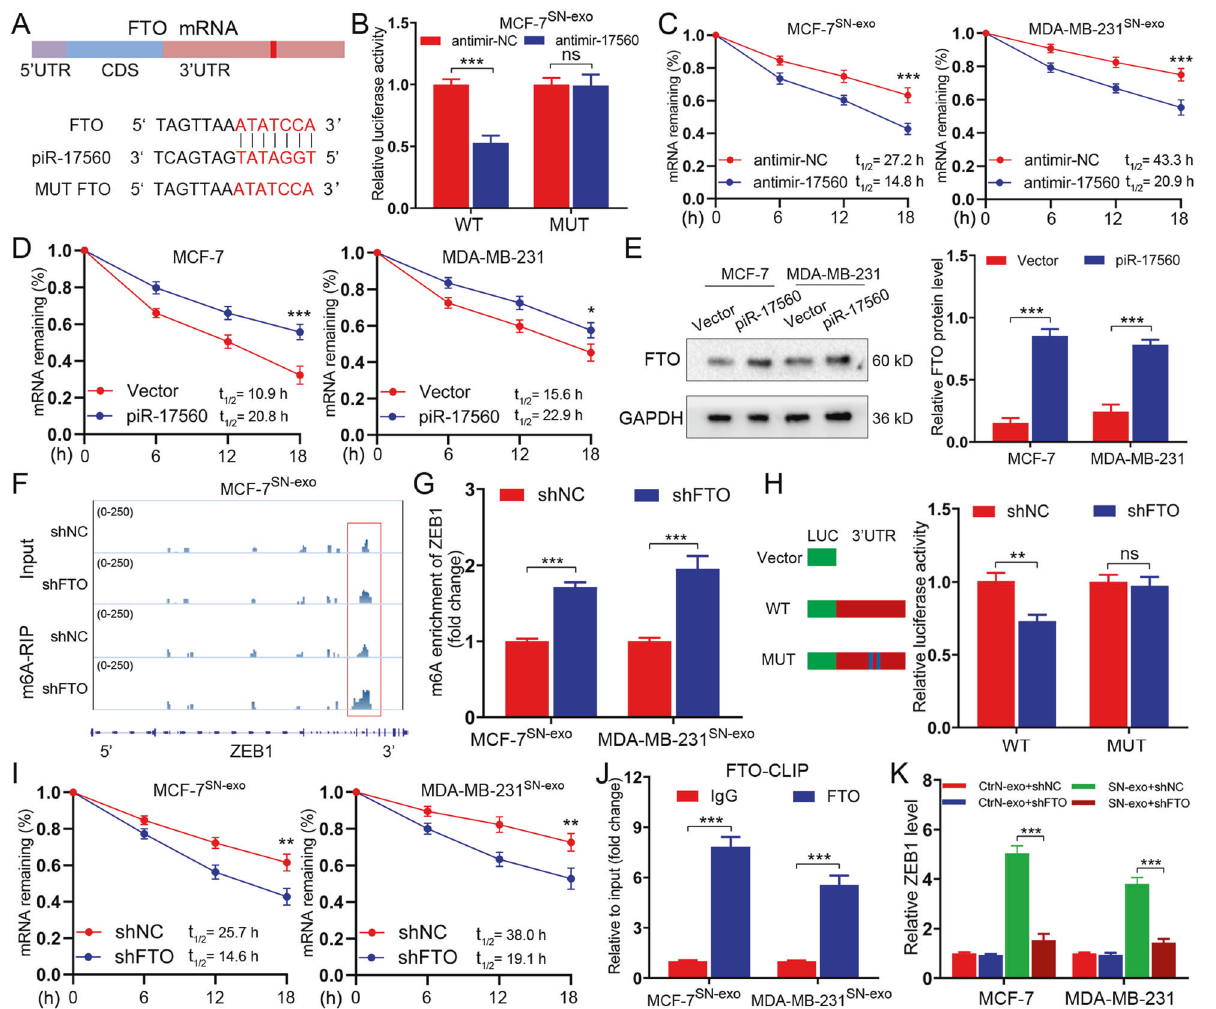
piRNA-17560 on FTO reporters with either wild-type (WT) or mutated binding sites. C The indicated cells were transiently transfected with antimir-17560 or antimir-NC. The half-life (t1/2) of FTO mRNA was measured. D MCF-7 or MDA-MB-231 cells were transiently transfected with antimir-17560 or antimir-NC. The half-life (t1/2) of FTO mRNA was tested. E Immunoblotting of FTO in MCF-7 and MDA-MB-231 cells with and without piR-17560 overexpression. F m6A peaks were enriched at ZEB1 mRNA from m6A-RIP sequencing data of FTO-depleted MCF-7 SN-exo cells. G m6A enrichment of ZEB1 in MCF-7 SN-exo and MDA-MB-231 SN-exo cells with or without FTO silencing. H Luciferase reporter assays showing the effect of FTO on ZEB1 reporters with wild-type (WT) or m6A mutated binding sites. I The indicated cells were transiently transfected with shFTO or shNC plasmids. The half-life (t1/2) of ZEB1 mRNA was examined. J CLIP-qPCR showing the association of ENO1 transcripts with WTAP in MCF-7 SN-exo and MDA-MB-231 SN-exo cells. K qPCR analysis of ZEB1 expression in tumor cells with and without